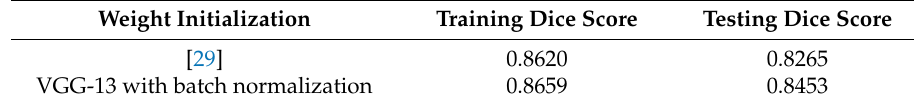
Table 2. Comparison of CNN-64-4-mod initialized with random weights and pretrained weights.